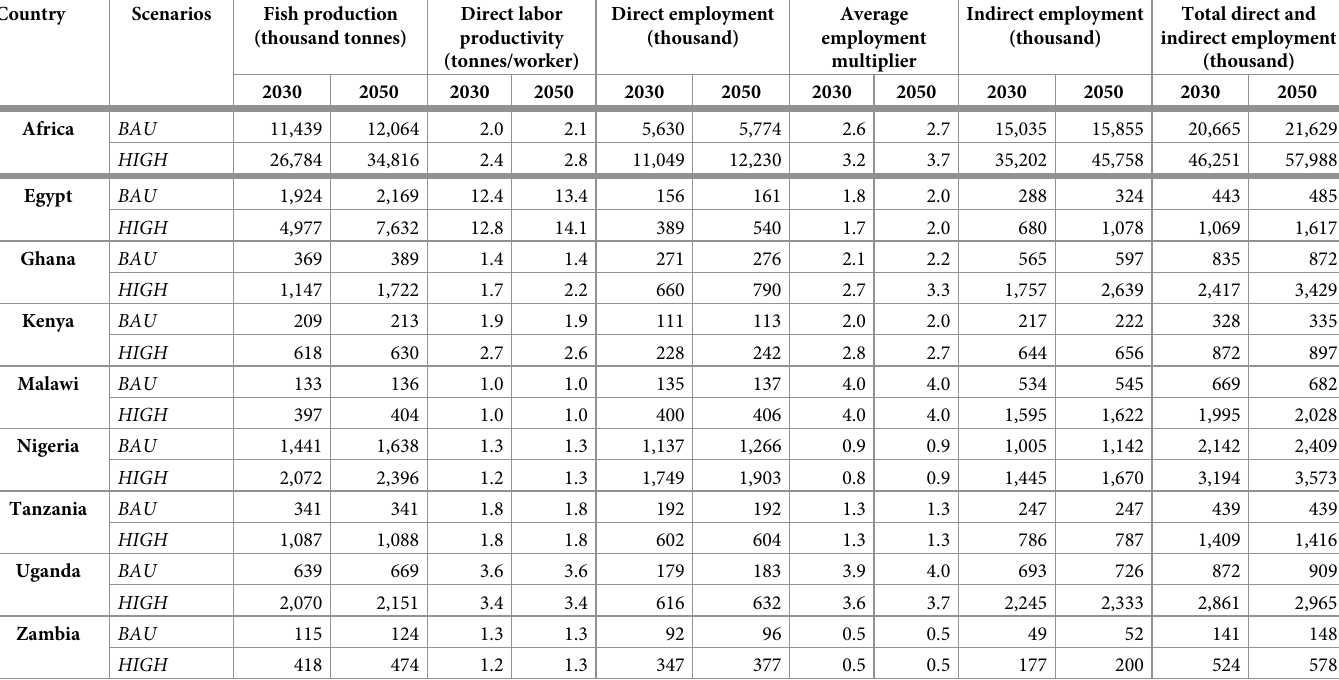
Table 4. Estimated direct and indirect employment of Africa’s fish food system for BAU and HIGH scenarios in 2030 and 2050. Country